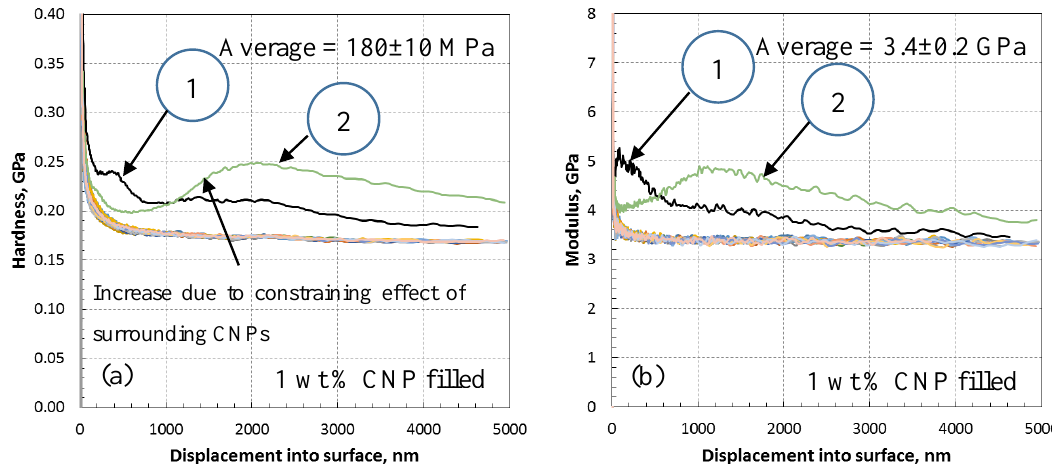
Figure 6. Nanoindentation data of 1 wt % CNP filled epoxy; ( a ) variation of hardness with depth showing non-steady hardness at or near CNPs (outliers 1 and 2 in Figure 7) with an average hardness of 180 ± 10 MPa, ( b ) variation of modulus with depth showing non-steady modulus at or near CNPs (outliers 1 and 2 in Figure 7) with average modulus of 3.4 ± 0.2 GPa.